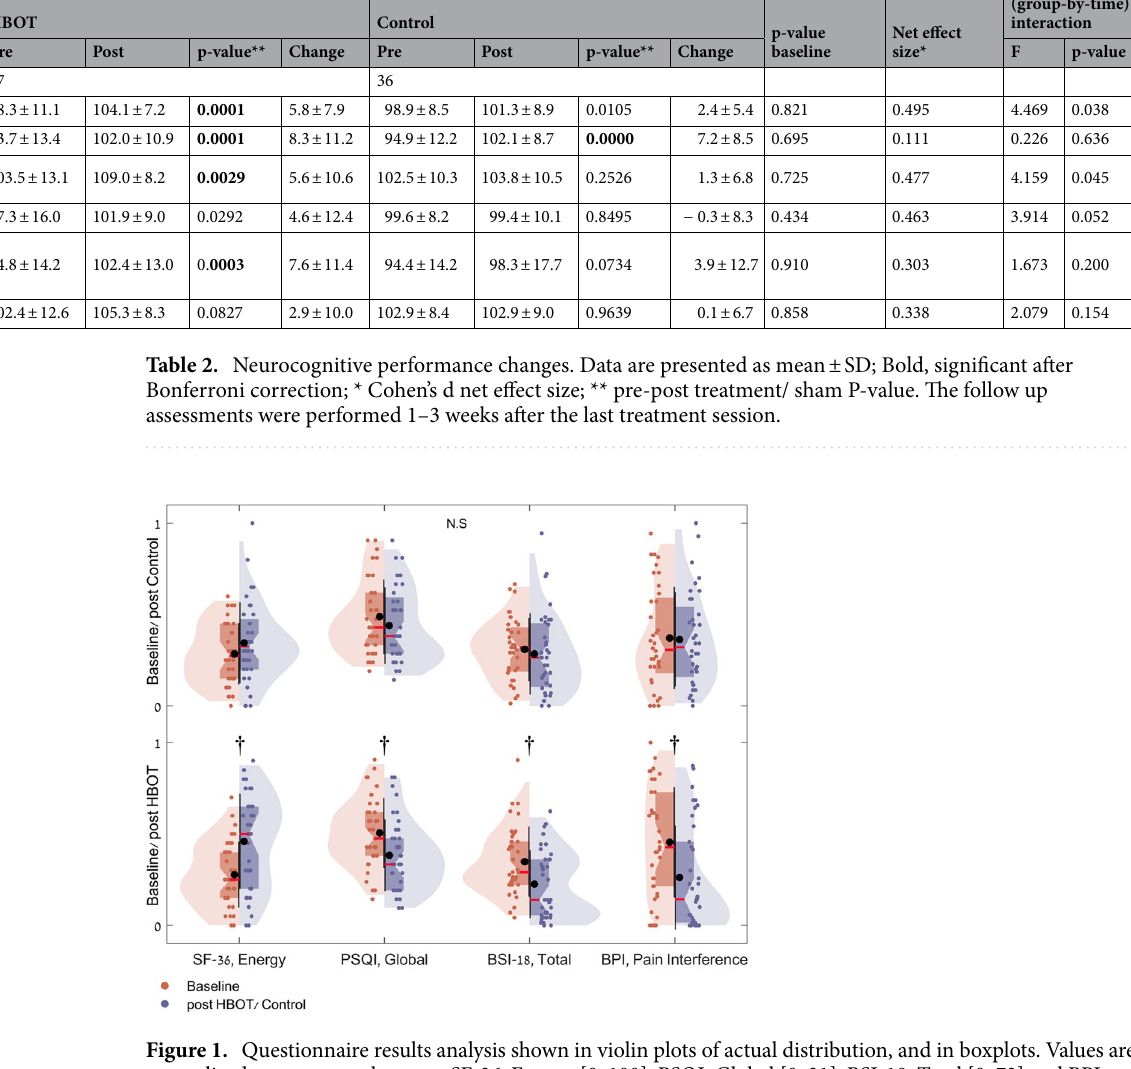
Figure 1. Questionnaire results analysis shown in violin plots of actual distribution, and in boxplots. Values are normalized to answer scale range: SF-36, Energy [0..100], PSQI, Global [0..21], BSI-18, Total [0..72] and BPI, Pain Interference [0..10]. The red mark indicates the median, and the bottom and top edges of the box indicate the 25th and 75th percentiles, respectively. Black marks indicate mean and standard deviation. † p < 0.0001, N.S. not significant (see also Table